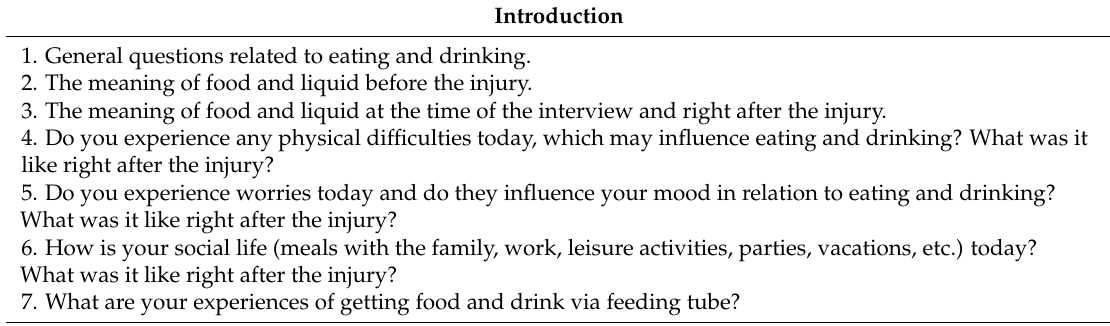
Table 2. Domains in the semi-structured interview